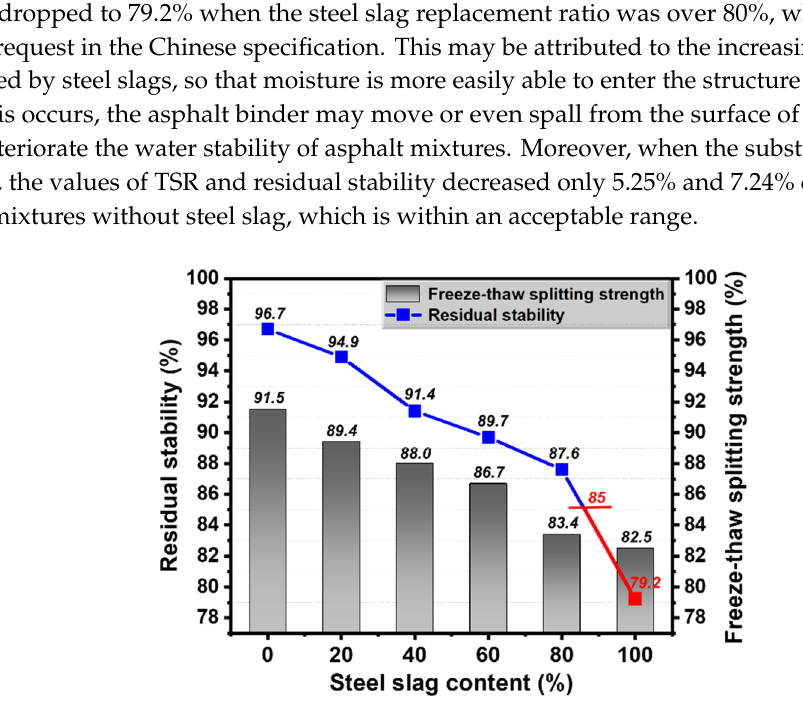
Figure 7. Low temperature performance of different steel slag contents.